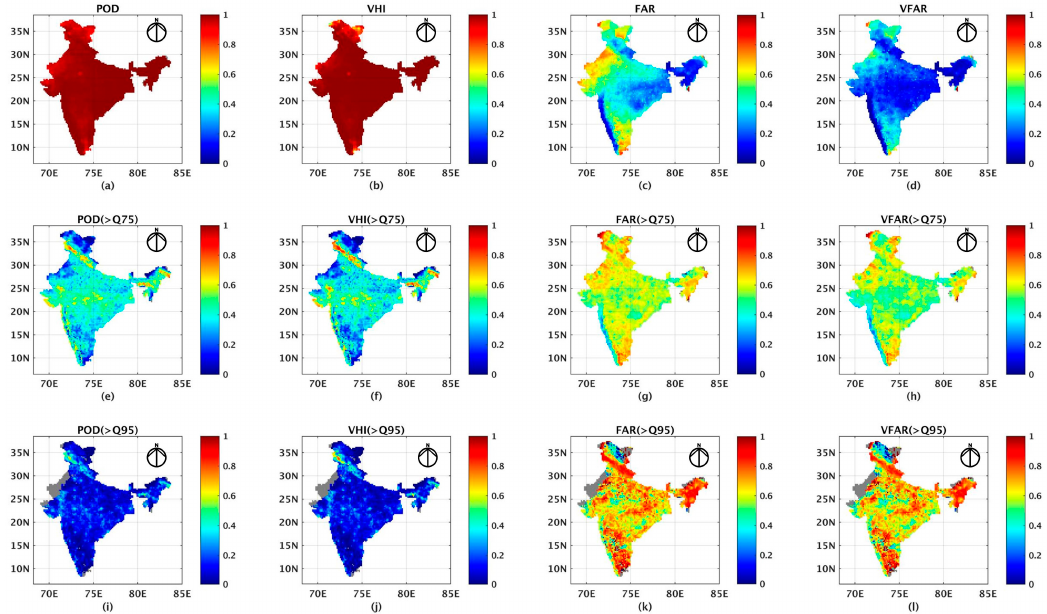
Figure 8. ( a – l ) Spatial distribution of categorical indices for the JJAS months over India for daily and higher quantiles of precipitation using MSWEP and IMD daily precipitation data from 1979 to 2013 showing POD ( a , e , i ); VHI ( b , f , j ); FAR ( c , g , k ); and VFAR ( d , h , l ).